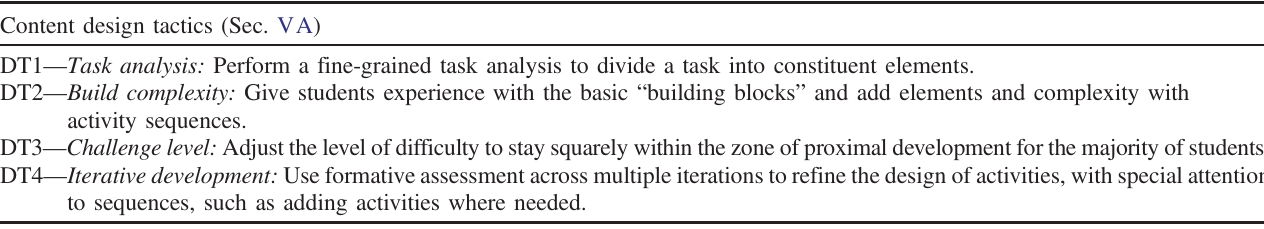
TABLE IV. A summary of the design tactics identified through analysis of the ring cycle. The sections indicate where each tactic is first introduced, but are not intended to imply that this is the only context to which that tactic applies. Content design tactics (Sec.